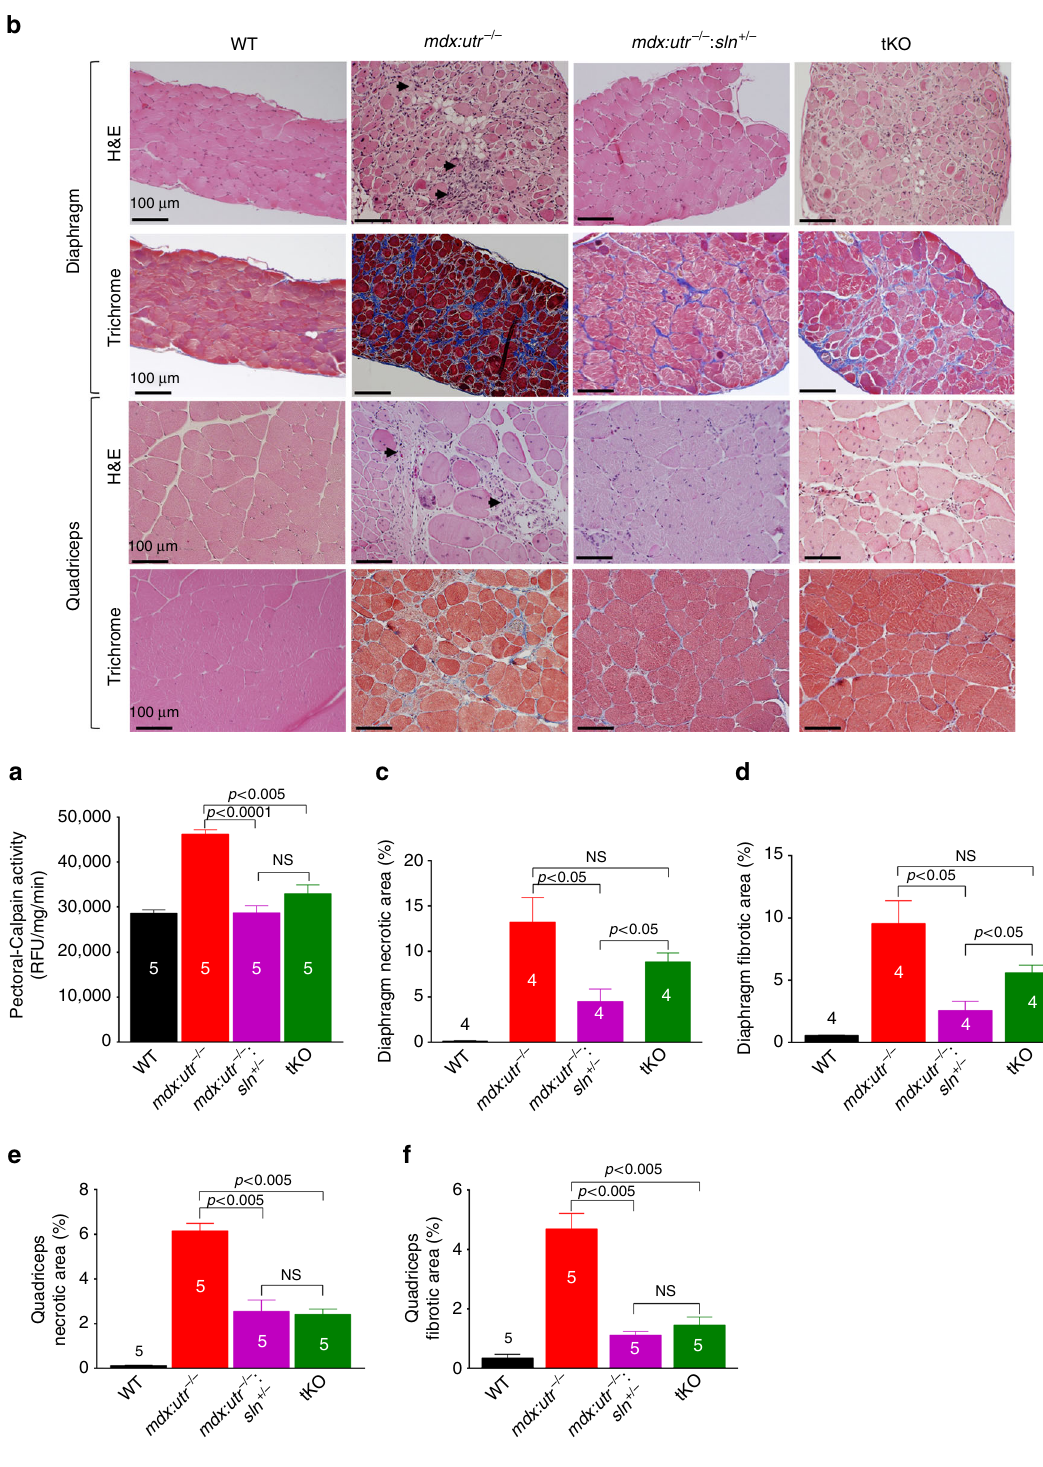
Fig. 2 Reduction in SLN expression ameliorates muscle pathology. a Calpain activity is restored to normal levels in the pectoral muscles of mdx:utr − / − :sln + / − and tKO mice. Data are presented as mean ± SEM ( t -test with Welch ’ s correction) of fi ve independent experiments performed in duplicates. The n number for each group is shown within the bar. b Representative H&E and Masson ’ s trichrome stained quadriceps and diaphragm muscles. Arrow indicates increased mononuclear in fi ltration (indicative of necrosis) and collagen (blue) accumulation (indicative of fi brosis) in mdx:utr − / − mice. Original magni fi cation is ×20. Scale bar = 100 μ m. c – f Quantitation show that the necrotic and fi brotic areas were signi fi cantly reduced in both diaphragm and quadriceps of mdx:utr − / − :sln + / − mice and in the quadriceps of tKO mice in comparison to that of mdx:utr − / − controls. The n number for each group and the p values ( t -test with Welch ’ s correction) are shown within the graph. Data are presented as mean ± SEM. Tissues from 3 to 4 month old mice are used